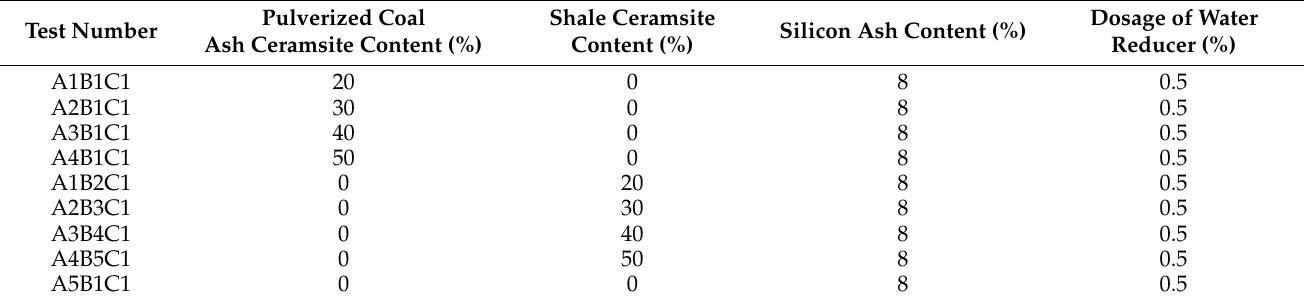
Table 1. Design test table of mix proportion of ceramsite CLHCPCS